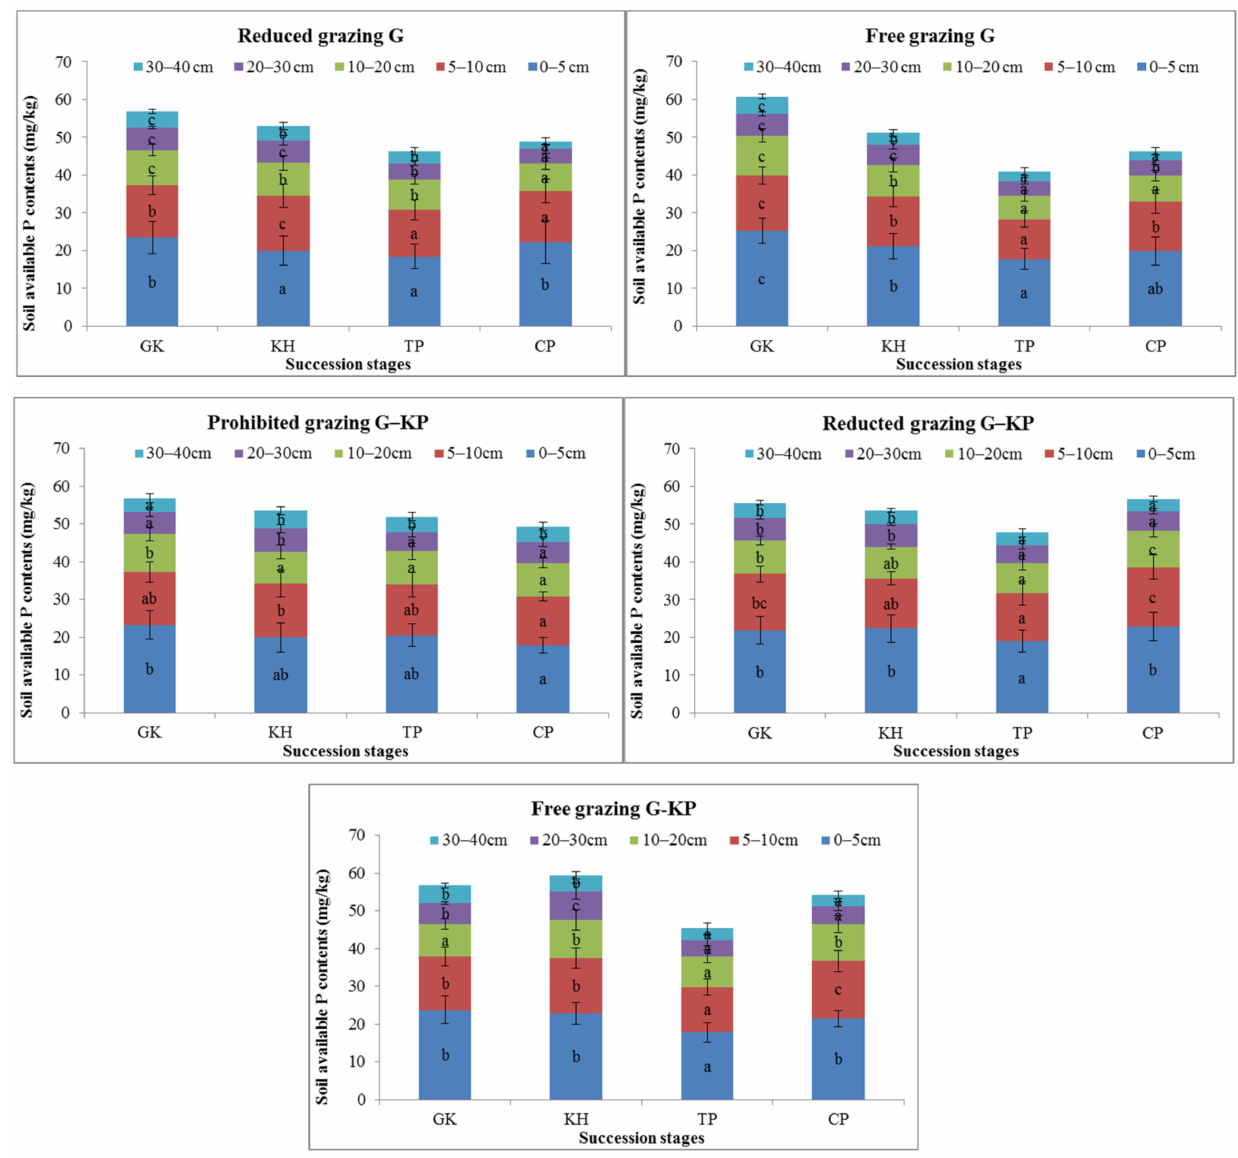
Figure 6. Variation in the available phosphorus content in alpine Kobresia meadows in different succession stages. Notes: G, Gramineae micro-patch; G-KP, Gramineae transformation to K. pygmaea micro-patch; KP, Kobresia micro-patch. “a”, “b”, and “c” are the coefficients of significance for the different degradation